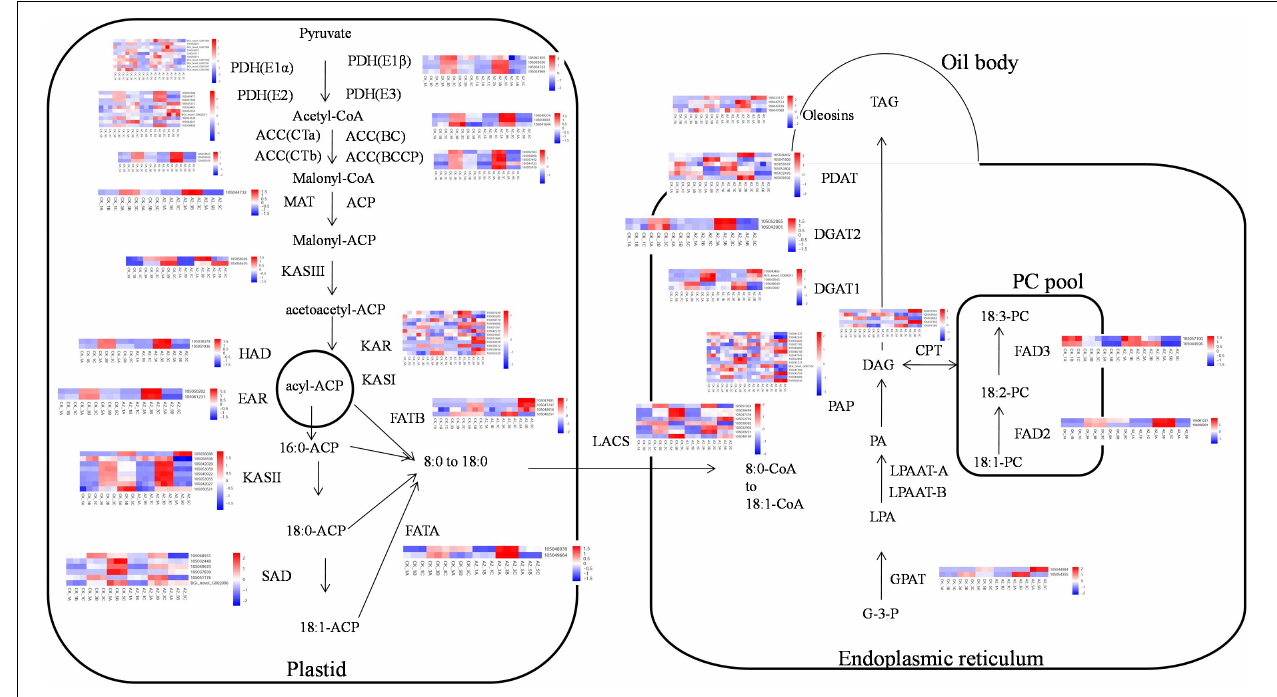
FIGURE 4 | The transcriptional model of fatty acid biosynthesis in developing oil palm mesocarp. The 18 squares in each horizontal row correspond to three replicates of three stages (16 WAP, 20 WAP, and 24 WAP) in CK and A2. G-3-P, glycerol-3-phosphate; LPA, 1-acylglycerol-3P; PA, phosphatidic acid; DAG, 1,2-diacylglycerol; and TAG, triacylglycerol.